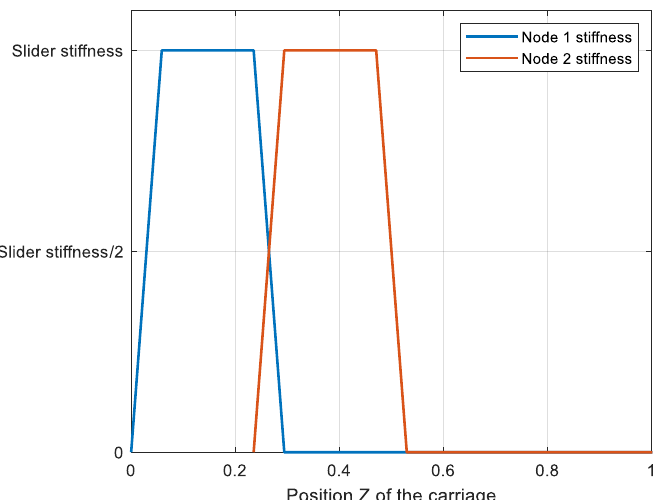
Figure 7. Sti ff ness function on a single node. The sti ff ness varies with the Z-coordinate. Two adjacent Figure 7. Stiffness function on a single node. The stiffness varies with the Z-coordinate. Two adjacent nodes are nodes are shown.